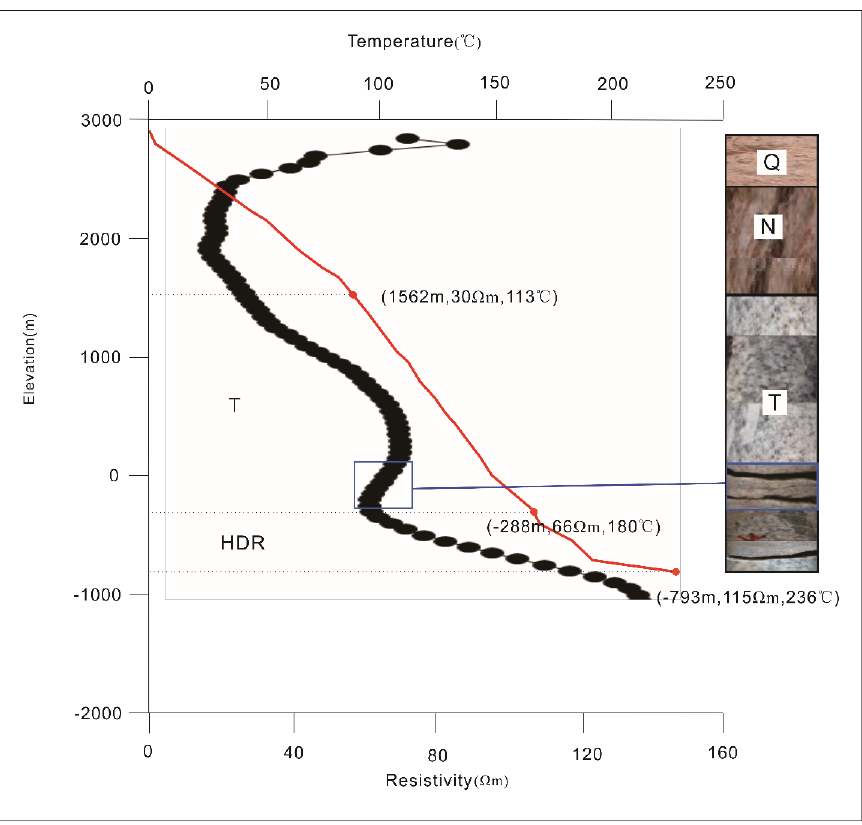
Figure 7. Resistivity vs. elevation: black dot curve; temperature vs. elevation: red curve.